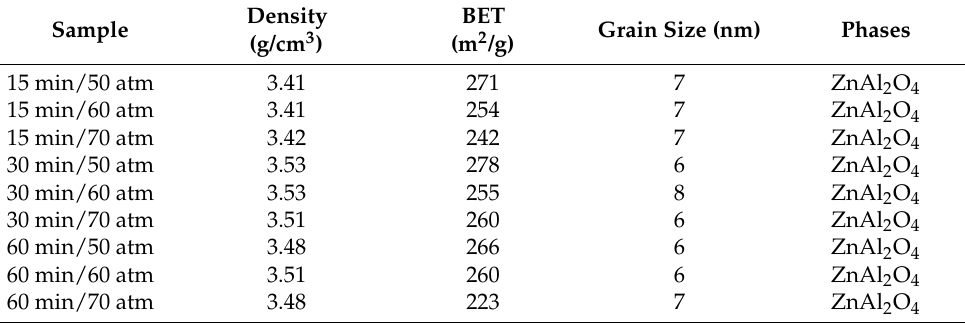
Table 2. Results of the analysis of zinc-aluminum spinel samples after synthesis.